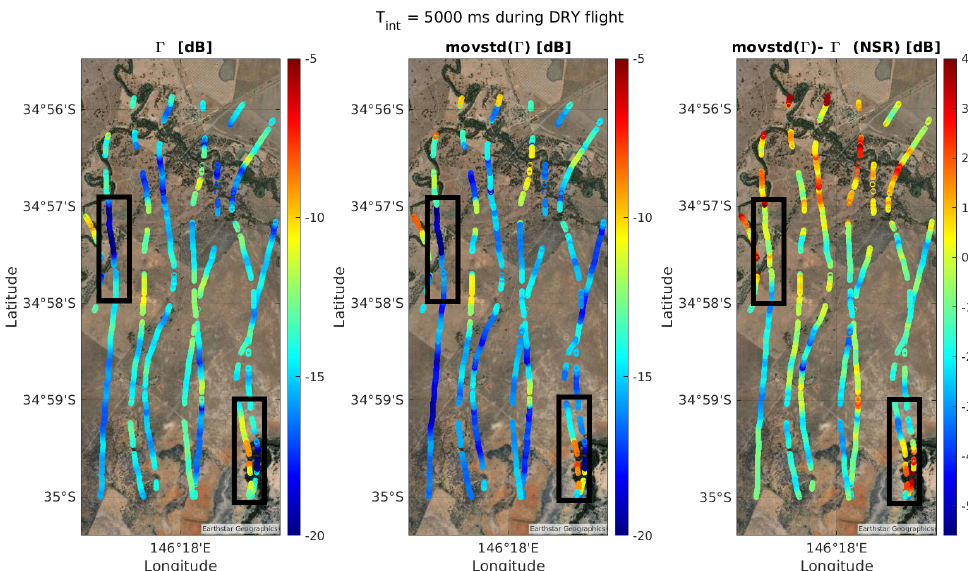
Figure 11. Geolocated Γ , movstd( Γ ), and Noise-to-signal ratio (NSR), defined as movstd( Γ ) − Γ , at T int = 5000 ms at L1 C/A for the Dry flight. Black boxes identify areas with reflectivity drops due to vegetated areas and an increase of the surface roughness.